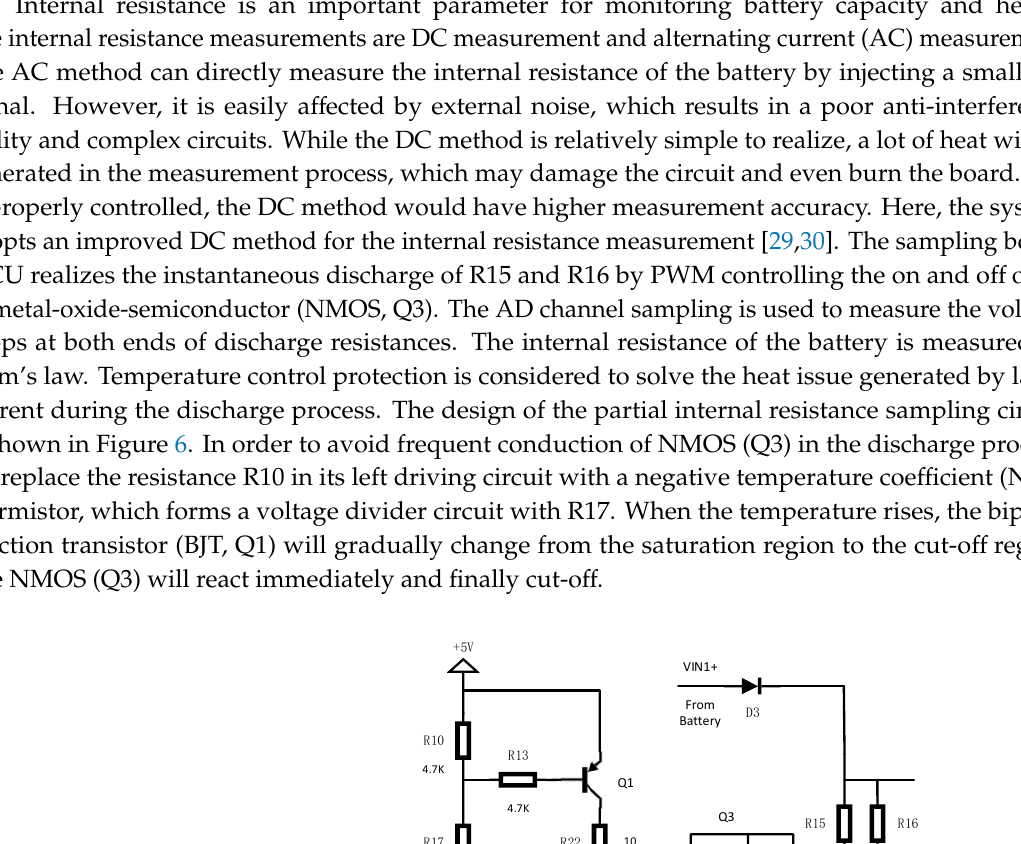
Figure 6. Partial internal resistance sampling circuit.